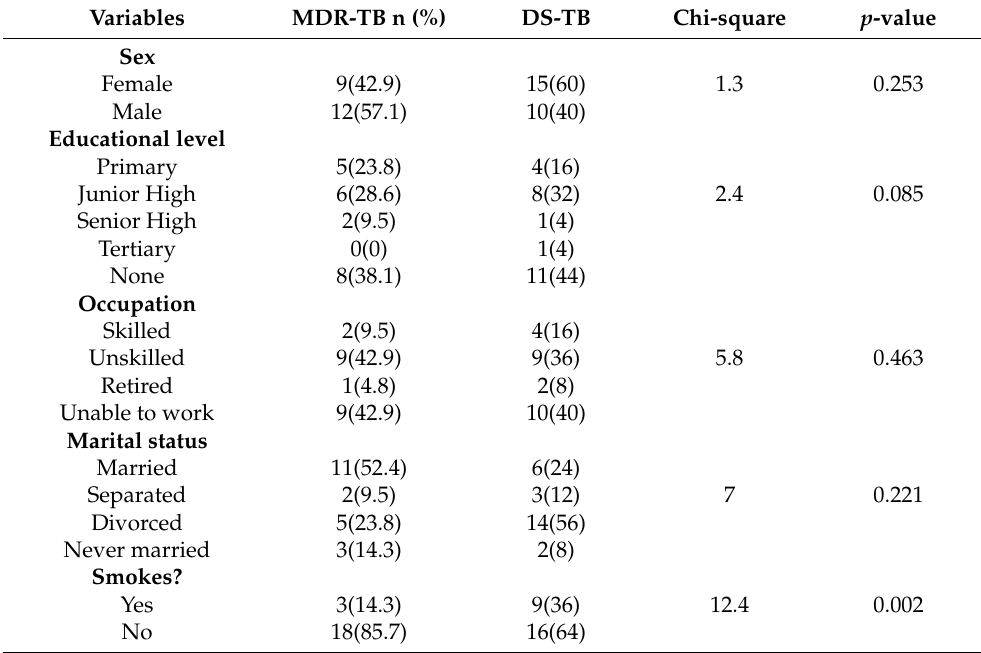
Table 1. Socio-demographic characteristics of MDR-TB and DS-TB